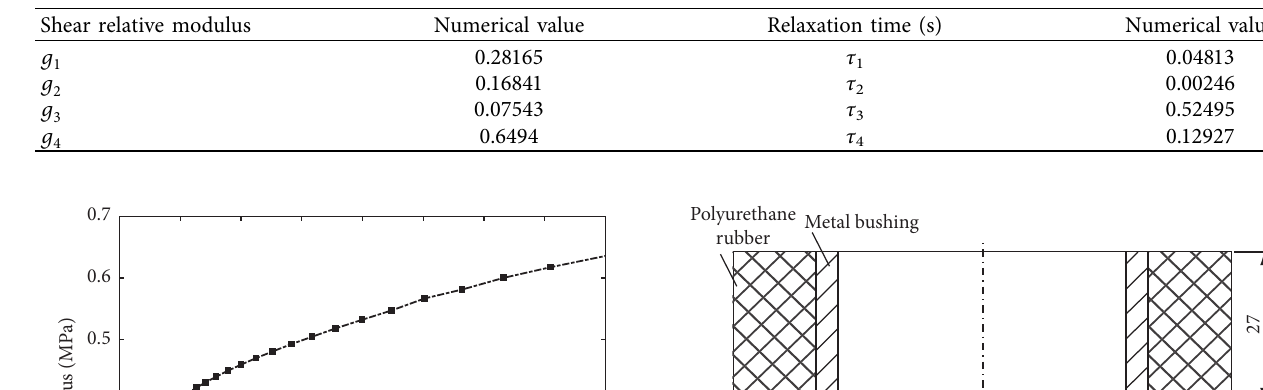
Table 2: Parameters of the fourth-order generalized Maxwell model.